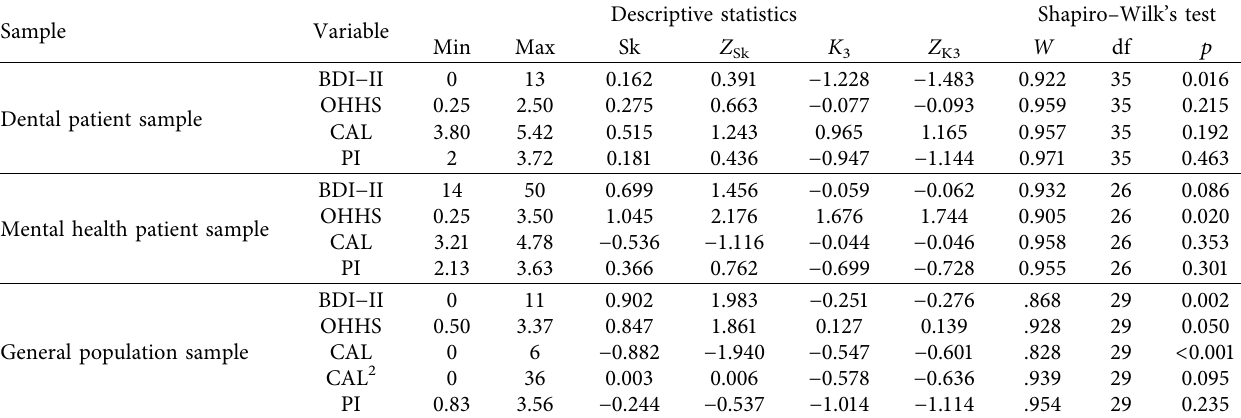
Table 5: Descriptive statistics and normality test in the sample of 35 dental